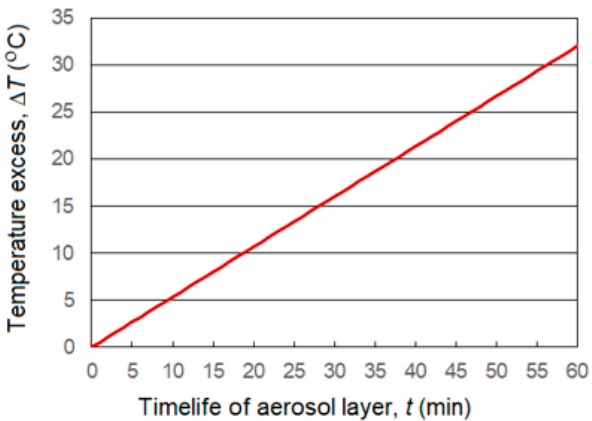
Figure 5. Time course of the conditional excess of the aerosol layer temperature over the environ- ment ( Δ T , °C), provided that the layer is immobile in height. The values of Δ T at surface wind speeds ( ∆ T , ◦ C), provided that the layer is immobile in height. The values of ∆ T at surface wind speeds of of 0.5 and 1.0 m/s are the same. 0.5 and 1.0 m/s are the